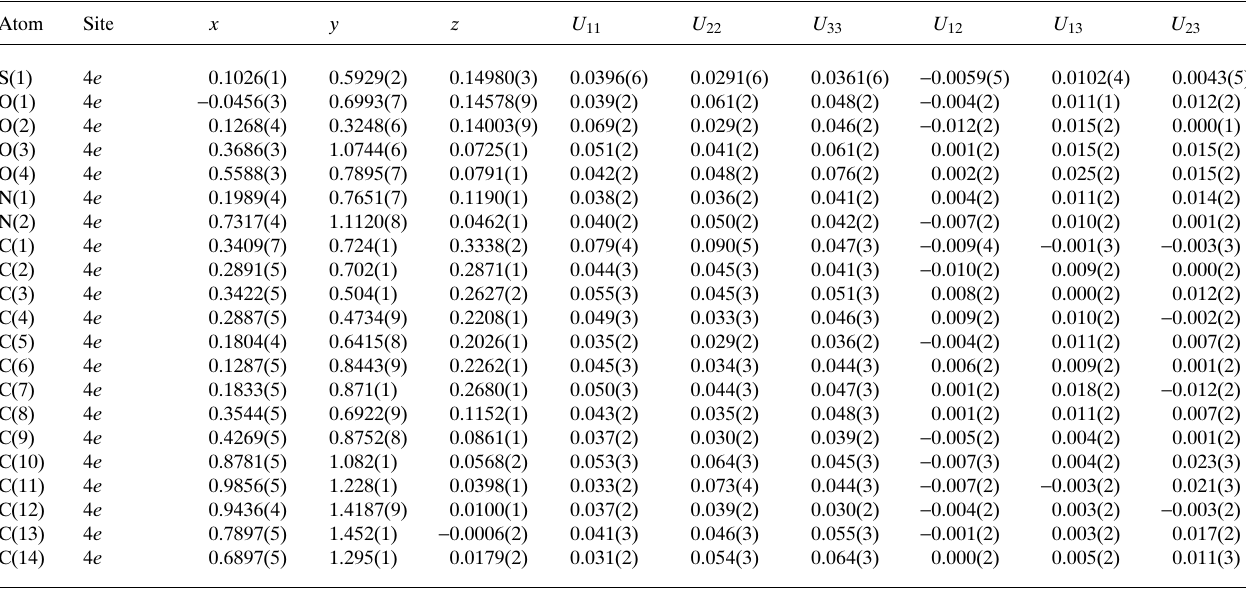
Table 3. Atomic coordinates and displacement parameters (in Å 2 )